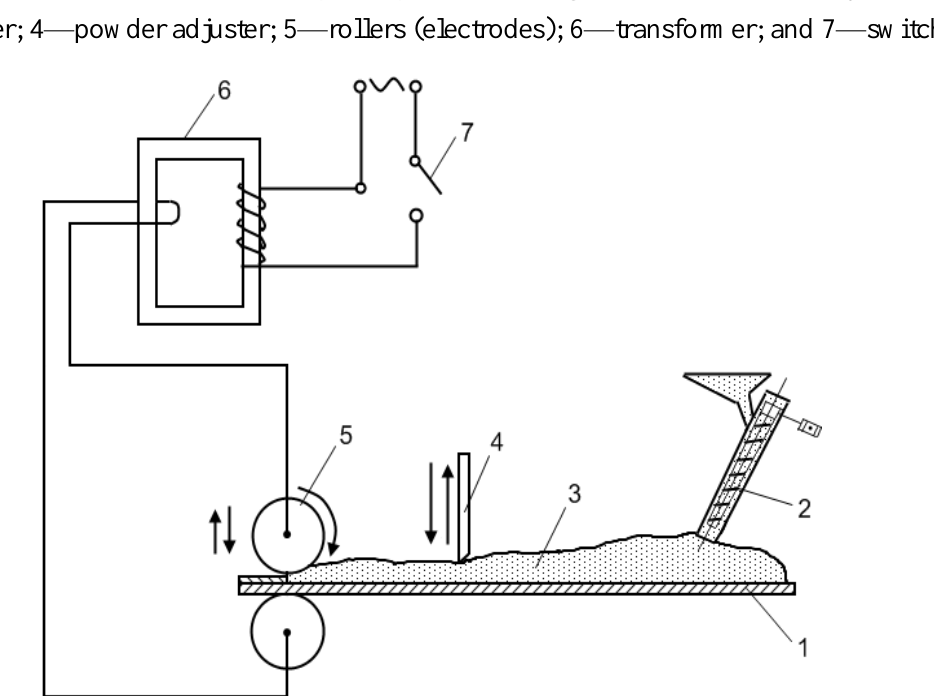
Figure 23. Schematic of the set-up for powder rolling: 1—table; 2—conveyer worm; 3—powder; 4—powder adjuster; 5—rollers (electrodes); 6—transformer; and